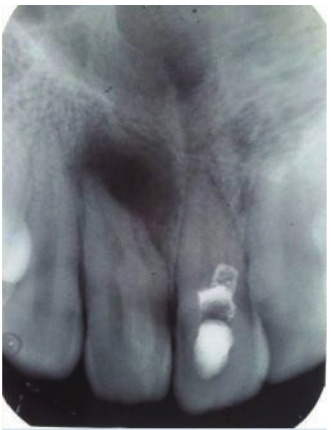
Figure 2: Intraoral periapical image.